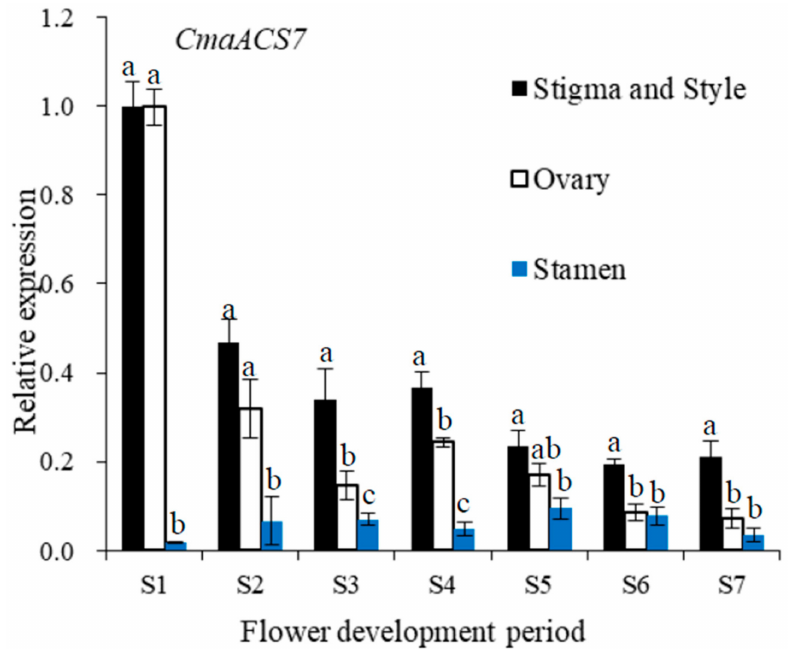
Figure 9. Relative expression of CmaACS7 at di ff erent stages (S1-S7) of ‘2013–12’ flower development using qRT-PCR analyses. The CmaACS7 expression at S1 ovary was assumed as unity. The relative expression level of CmaACS7 in ovary, stigma and style was significantly high, while less expression was observed in stamen. Data are displayed as the ratio of expression to CmaActin with three biological replicates. Error bars represent standard error (SE). The qRT-PCR of primers used are given in Table S3. Phytohormone levels followed by the same lowercase letter are not significantly di ff erent at p < 0.05 using SSR’s